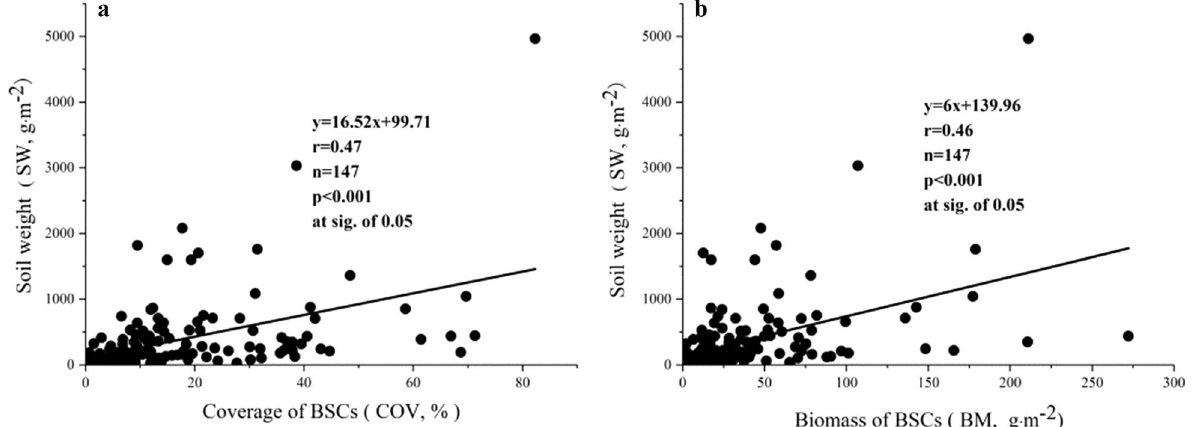
Fig. 8 Relationship between SW and COV ( a ) and BM ( b ) at different sampling